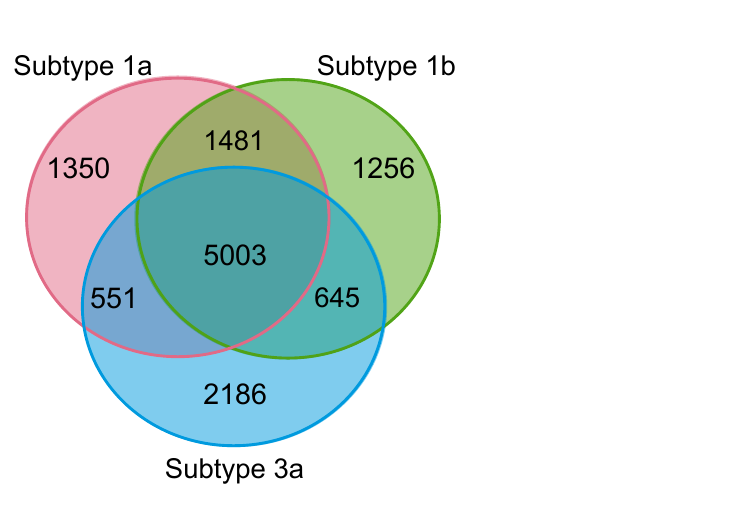
Figure 4. Venn diagram showing the number of sites that were ‘conserved’ (have the same nucleotide and mutation type) between subtypes.